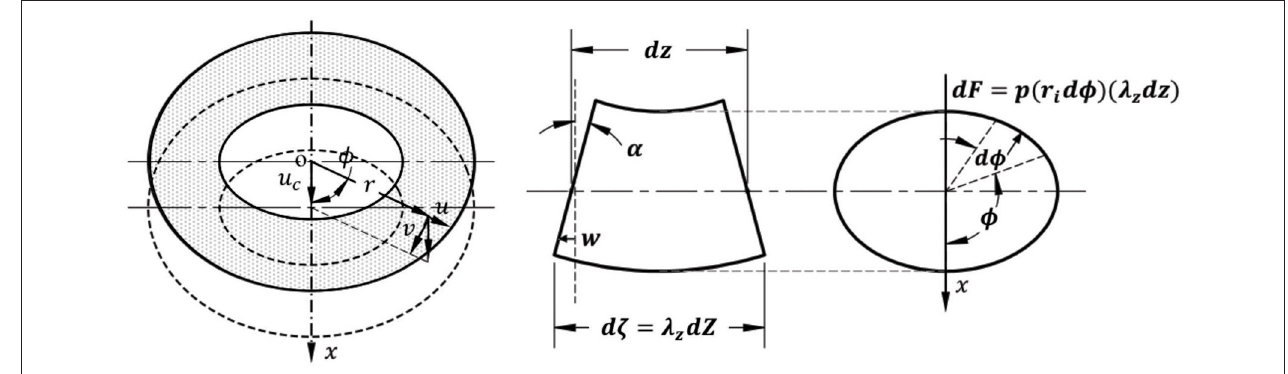
FIGURE 2 | Schematic illustration of the relationship between wall displacement and central axis deflection (left) , a deformed segment of a buckled artery in lateral view (middle) , and cross-sectional view (right) . α represents the rotation angle of a cross-section.